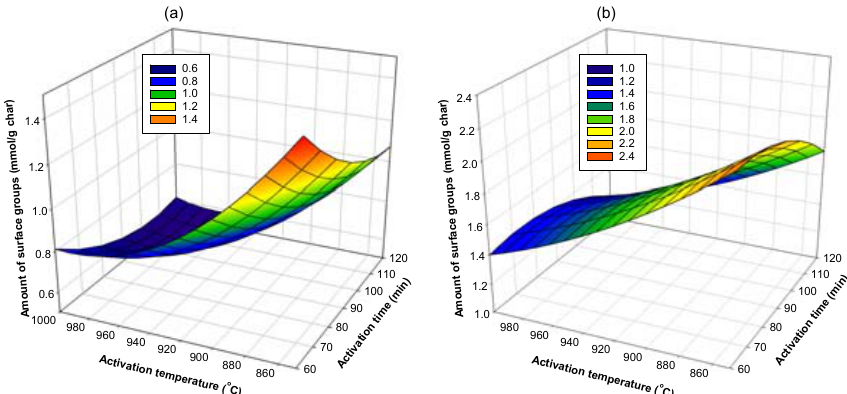
Figure 18. Surface response curves showing the effects of activation temperature and activation time